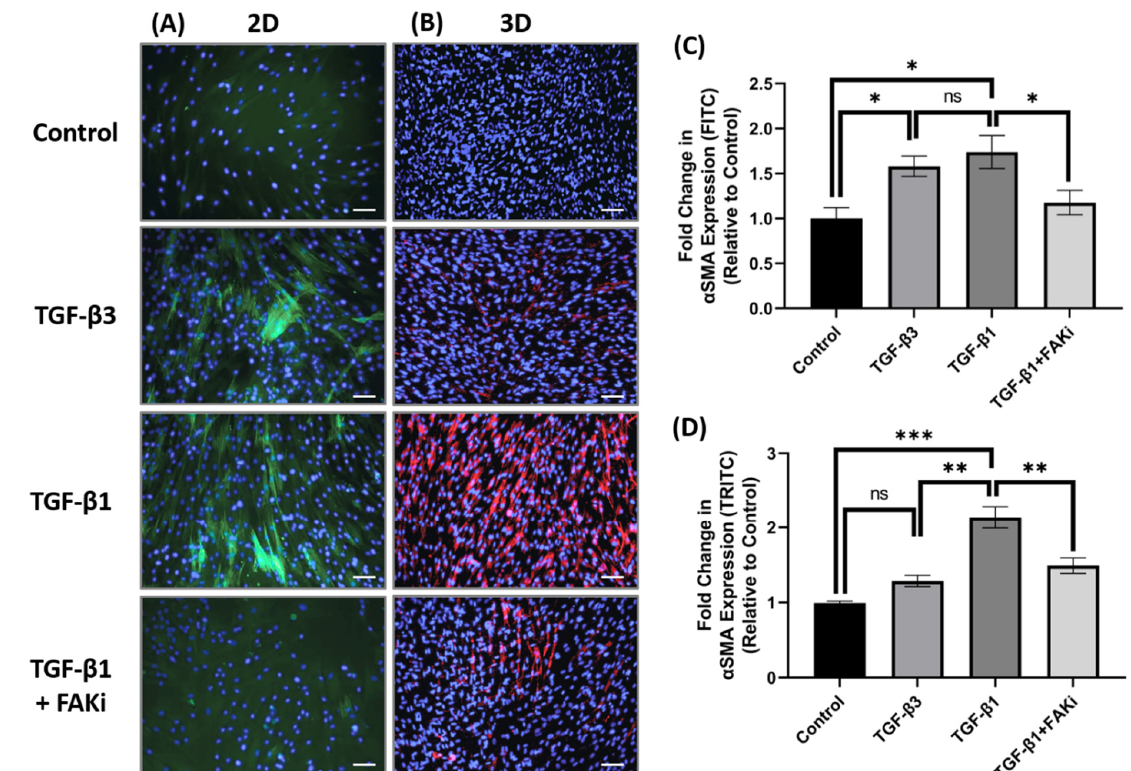
Figure 3. FAK inhibition decreased expression of α SMA in 3D hCF constructs. ( A ) In 2D cell culture (2D), hCF were growth arrested 48 h prior to stimulation with either no growth factors (control), TGF- β 3, TGF- β 1, or TGF- β 1 + FAK inhibitor (FAKi). After a further 24 h, the 2D cultures were examined for α SMA localization. Green = α SMA, Blue = TO-PRO-3. ( B ) In 3D constructs, hCF constructs were generated and stimulated with vitamin C to secrete their own extracellular matrix for 2 weeks. 3D hCF constructs were treated with either no growth factors (control), TGF- β 3, TGF- β 1, or TGF- β 1 + FAKi. After a further 24 h, the 3D constructs were examined for α SMA localization. Red = α SMA, Blue = TO-PRO-3. Images of ( C ) 2D cell culture and ( D ) 3D constructs were captured, and fluorescent intensity of α SMA was quantified using Image-J software. Average fold change of fluorescent intensity relative to control is shown for all experimental groups ±SEM. All images were taken at 20× magnification. Scale bar: 50 μ m. Representative western blot images of α SMA and FAK via dif- ferent treatment groups are shown. n = 3 per group. ns : non-significant, * p < 0.05, ** p < 0.01, *** p < 0.001. ACTA2, Alpha smooth muscle actin; FAK, Focal Adhesion Kinase.